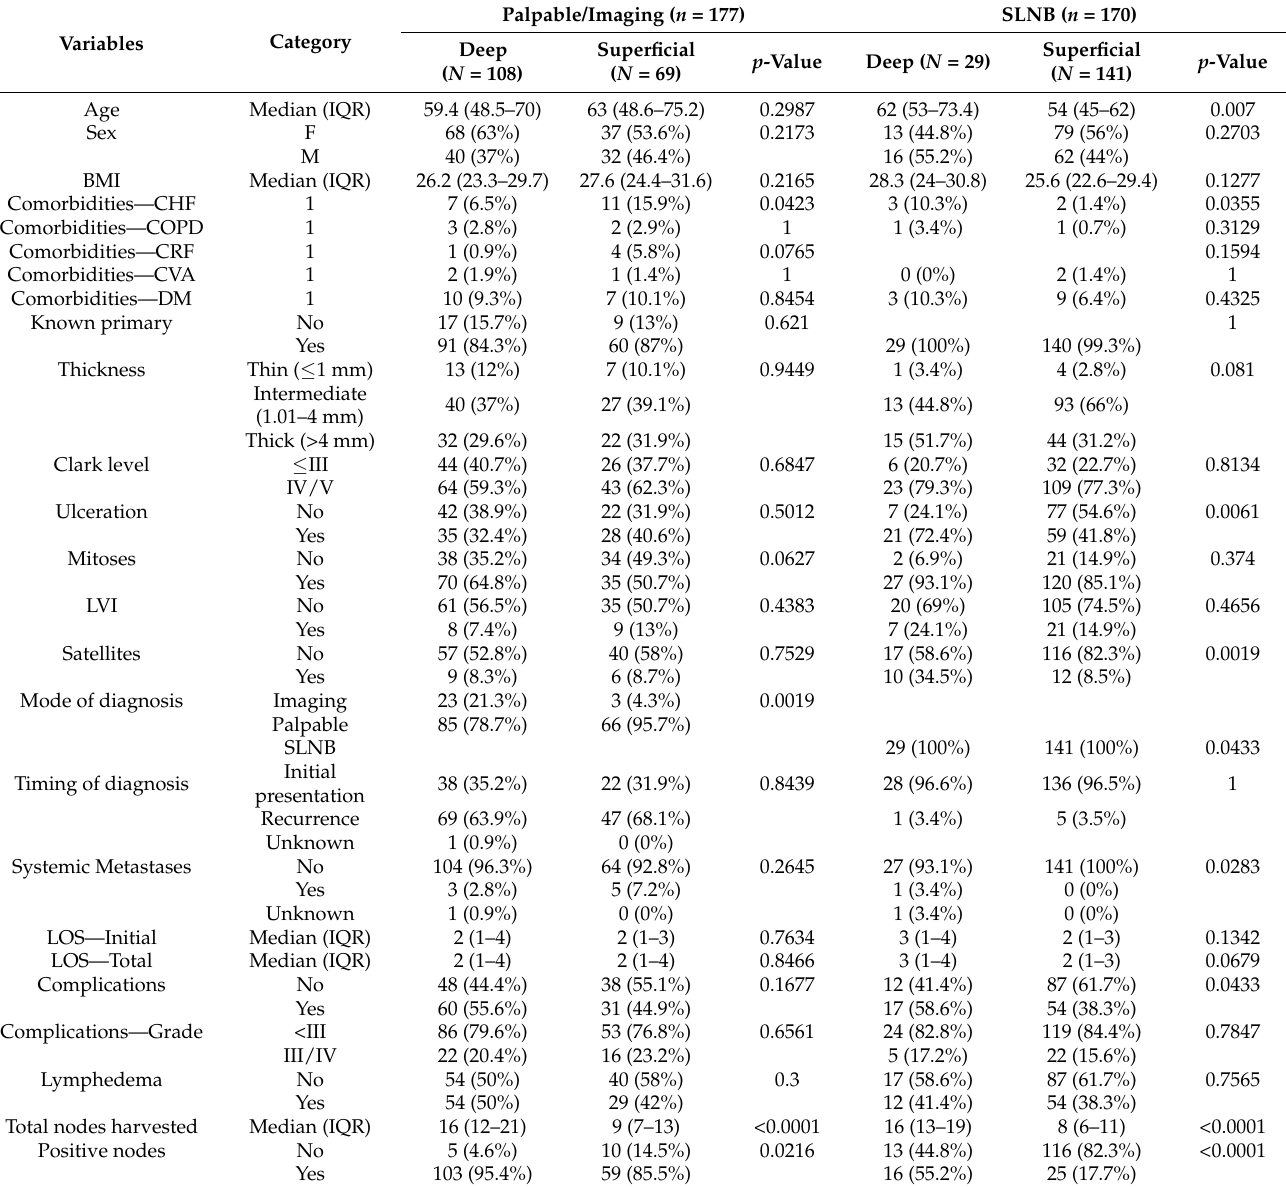
Table 2. Patient demographics and outcomes by presentation and